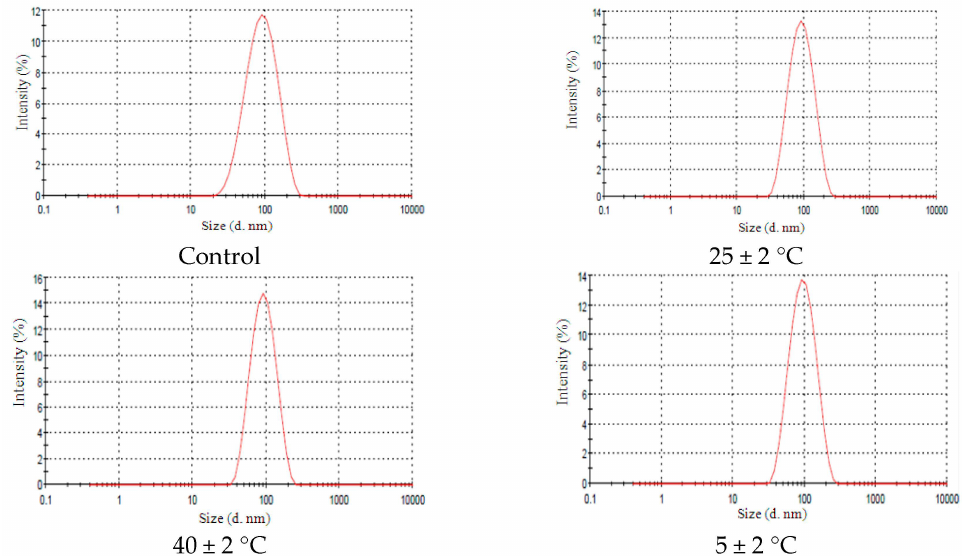
Figure 7. Narrow droplet size NE-EL 6% distribution under different conditions after 90 days of storage. Control curve refers to initial time (0 day), 25 ˘ 2 ˝ C refers NE-EL 6% stored at room temperature. 40 ˘ 2 ˝ C refers NE-EL 6% stored at high temperatures and 5 ˘ 2 ˝ C refers NE-EL 6% stored at low